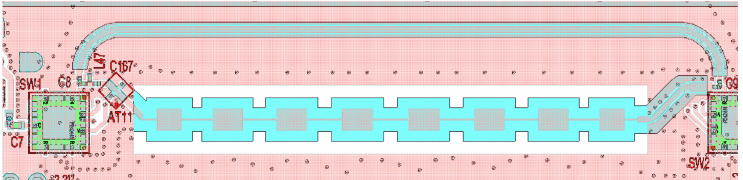
Figure 8. Detail of the switch filter bank section showing the BPF-A between two commercial ultra CMOS SP4T RF switches (Peregrine